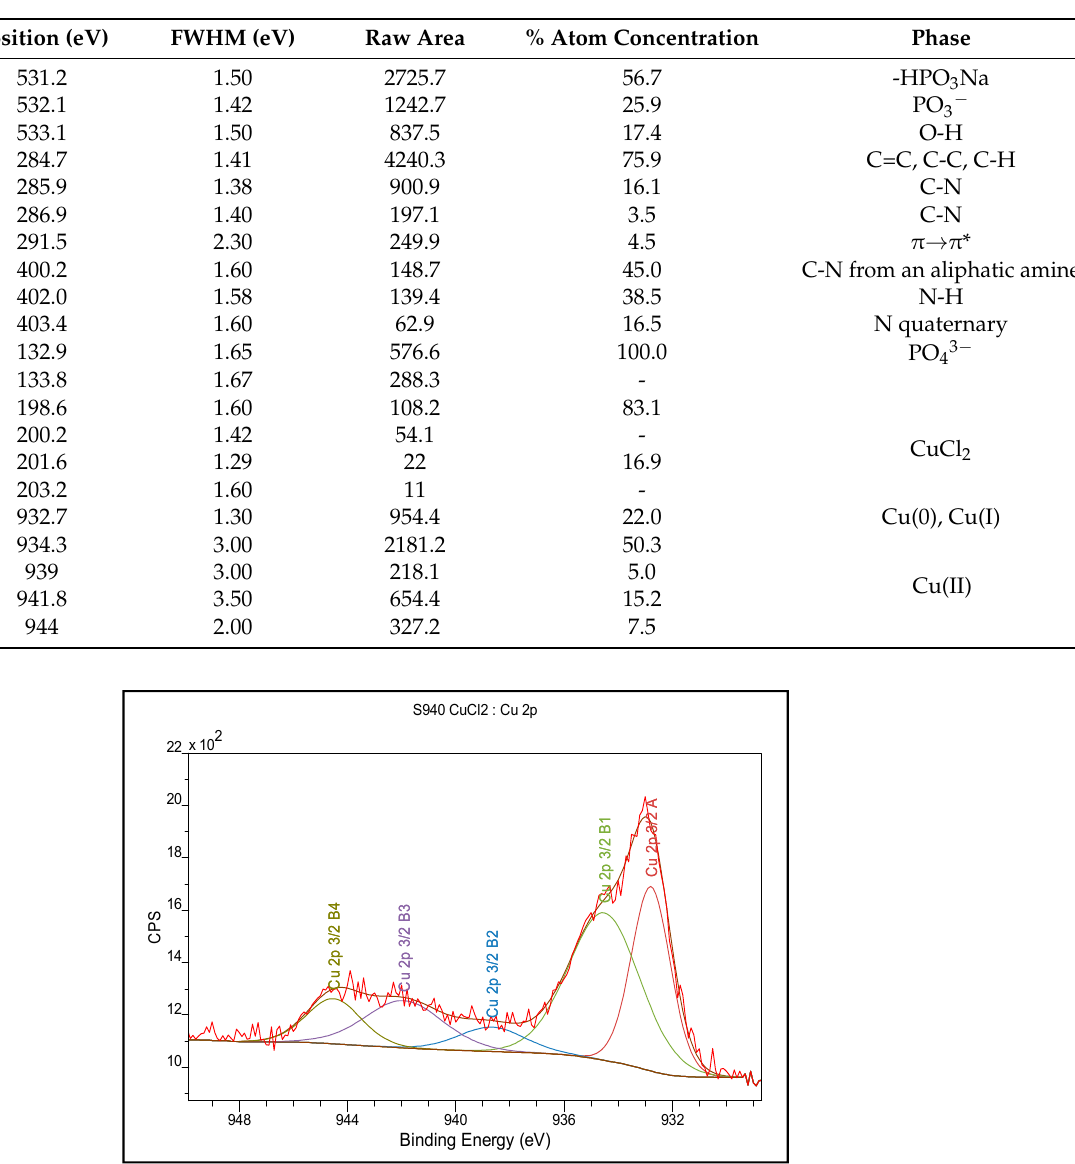
Table 7. The XPS analysis results obtained in the narrow range of binding energies for Purolite S 940 after the Cu(II) ions sorption.